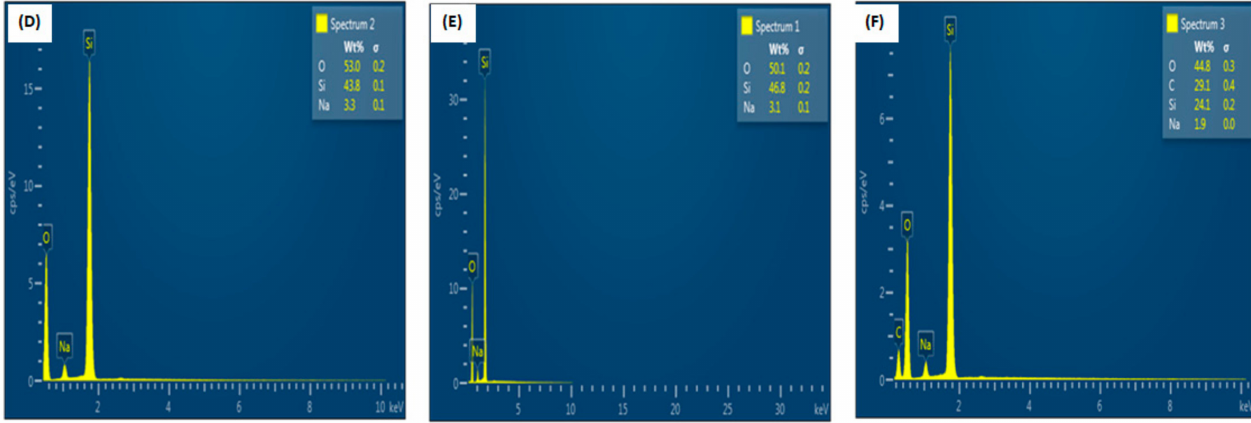
Figure 3. SEM ( A ) ACT-MIP (before template removal), ( B ) ACT-MIP and ( C ) NIP and EDS images of ( D ) ACT-MIP (before template removal), ( E ) ACT-MIP and ( F ) NIP.